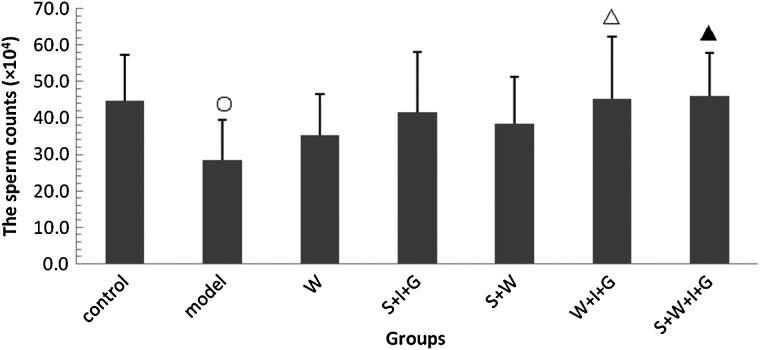
Sperm counts in experimental mice. Compared with the control group: open circle: P < 0.05. Compared with the model group: open triangle: P < 0.05, closed triangle: P < 0.01.